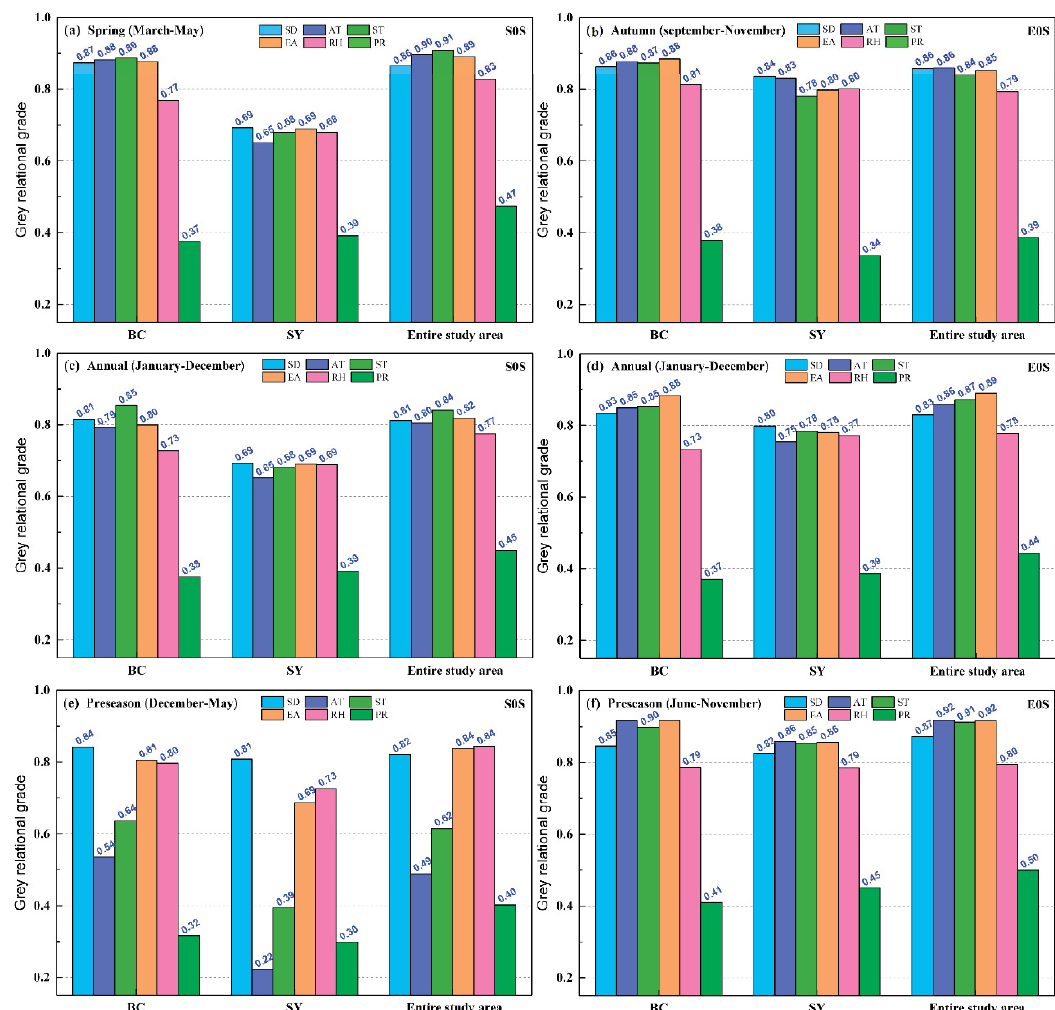
Figure 6. Grey relational analysis between phenology (SOS and EOS) and climatic factors (SD, AT, ST, EA, RH, and PR). ( a ) GRA between the SOS and climatic factors in spring (March–May), ( b ) GRA between the EOS and climatic factors in autumn (September–November), ( c ) GRA between the SOS and the annual (January–December) climatic factors, ( d ) GRA between the EOS and the annual (January–December) climatic factors, ( e ) GRA between the SOS and the SOS preseason (December–May) climatic factors, ( f ) GRA between the EOS and the EOS preseason (June–November) climatic factors. The EOS of P. euphratica was mainly affected by the EOS preseason